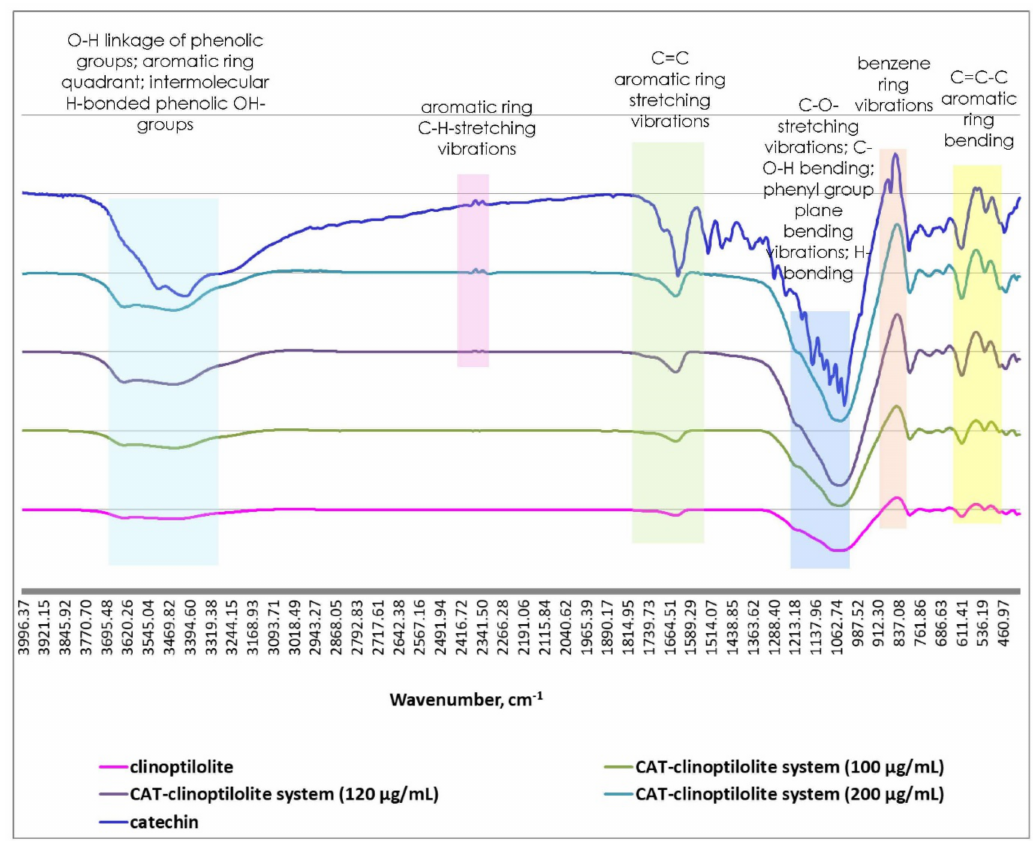
Figure 3. FTIR spectra of spray-dried catechin powder, clinoptilolite and catechin-loaded